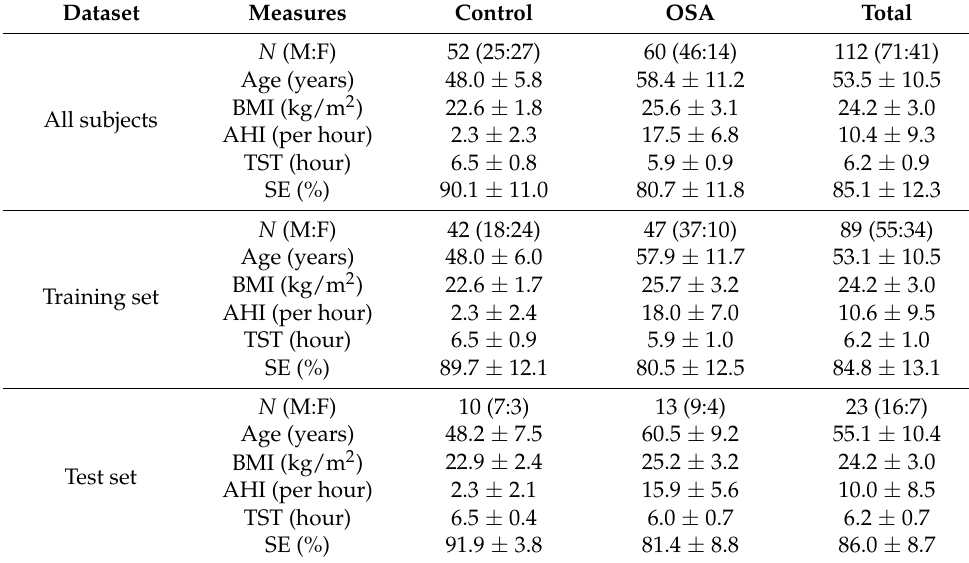
Table 1. Demographics of the study population.